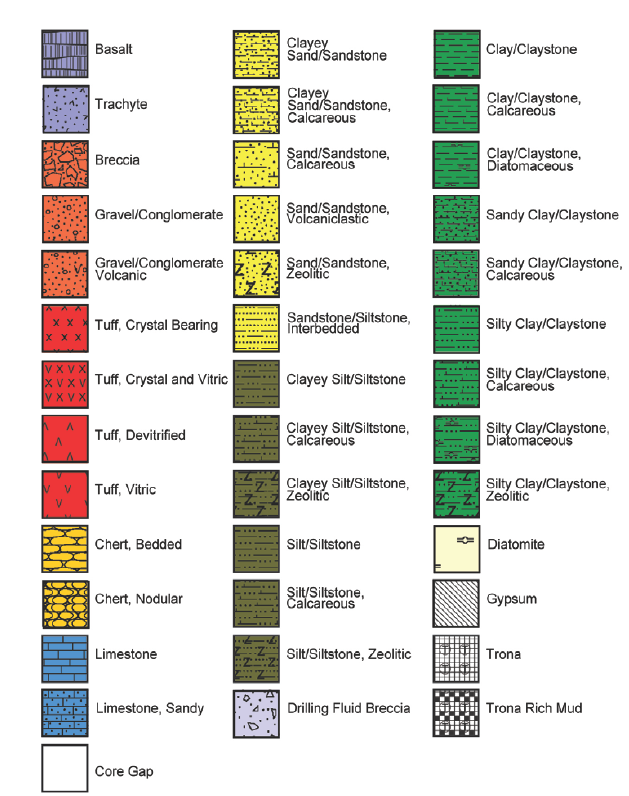
Figure 4. Key to all lithologic symbols. Note that blank (white) areas in lithologic columns indicate zones of missing core, i.e., no core recovery.